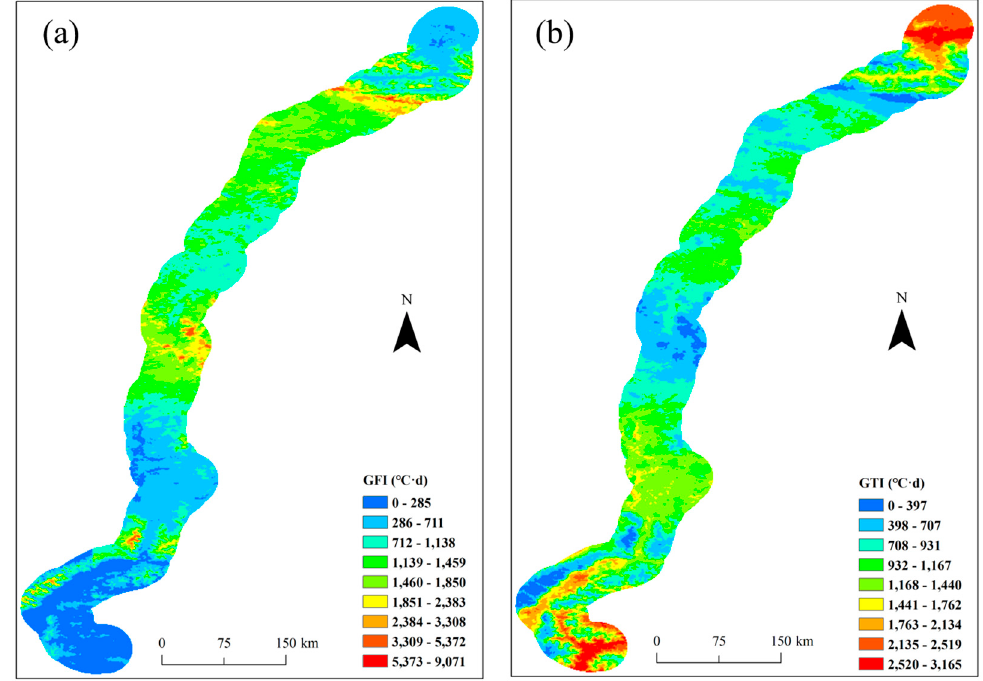
Figure 4. GFI and GTI of QTEC: ( a ) GFI and ( b )